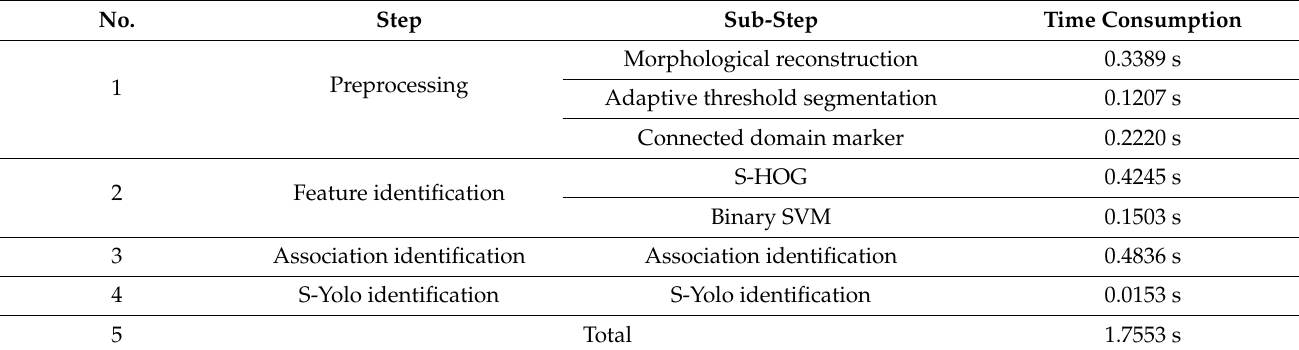
Table 4. Time consumption for each step in the actual test process.